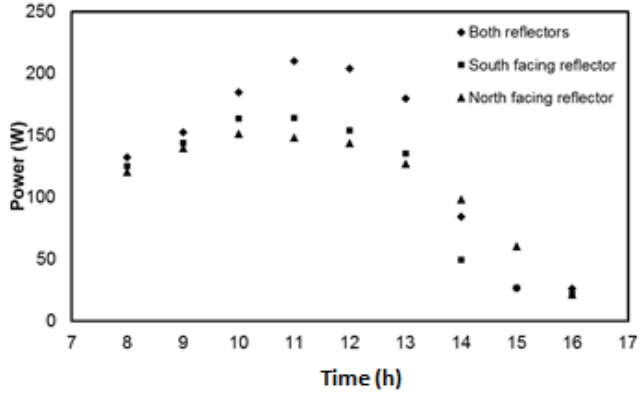
Figure 20. Comparison of both reflectors power output.